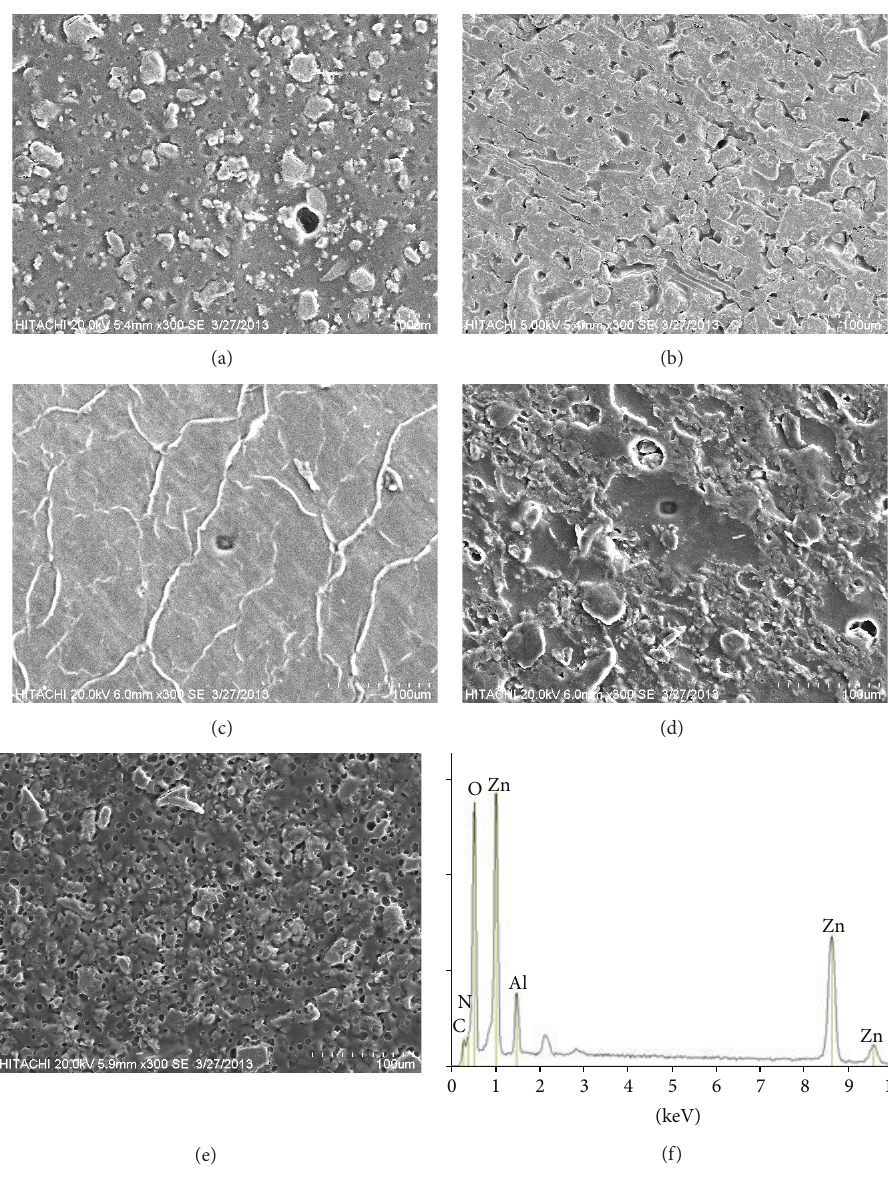
Figure 4: SEM images of (a) 1%wt, (b) 3%wt, (c) 5%wt, (d) 7%wt, and (e) 9%wt PVC-LDH, (f) EDX of